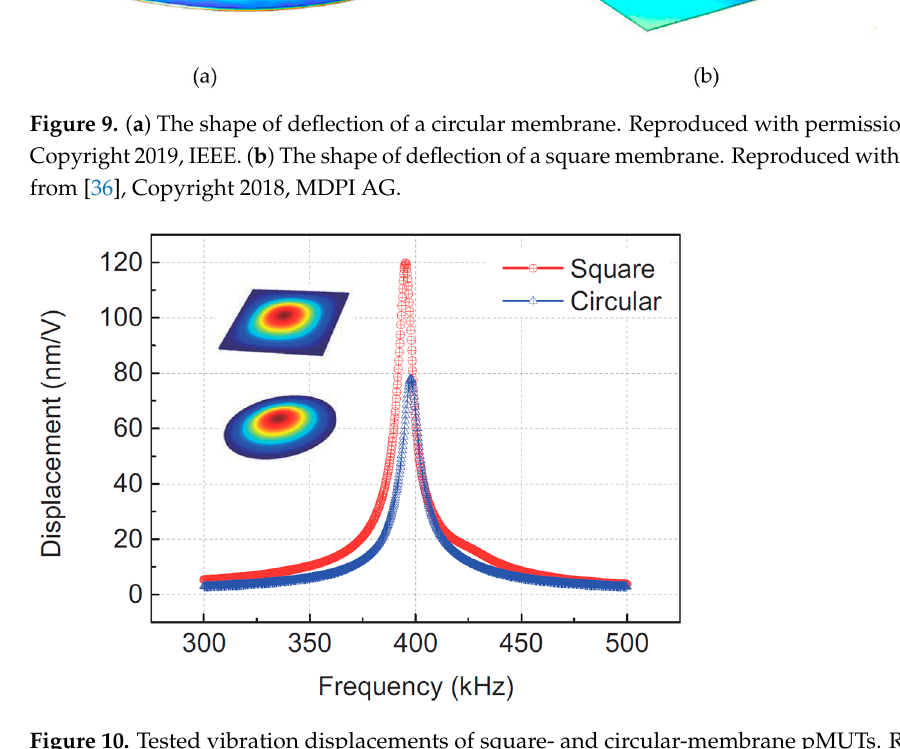
Figure 10. Tested vibration displacements of square- and circular-membrane pMUTs. Reproduced with permission from [71], Copyright 2018,